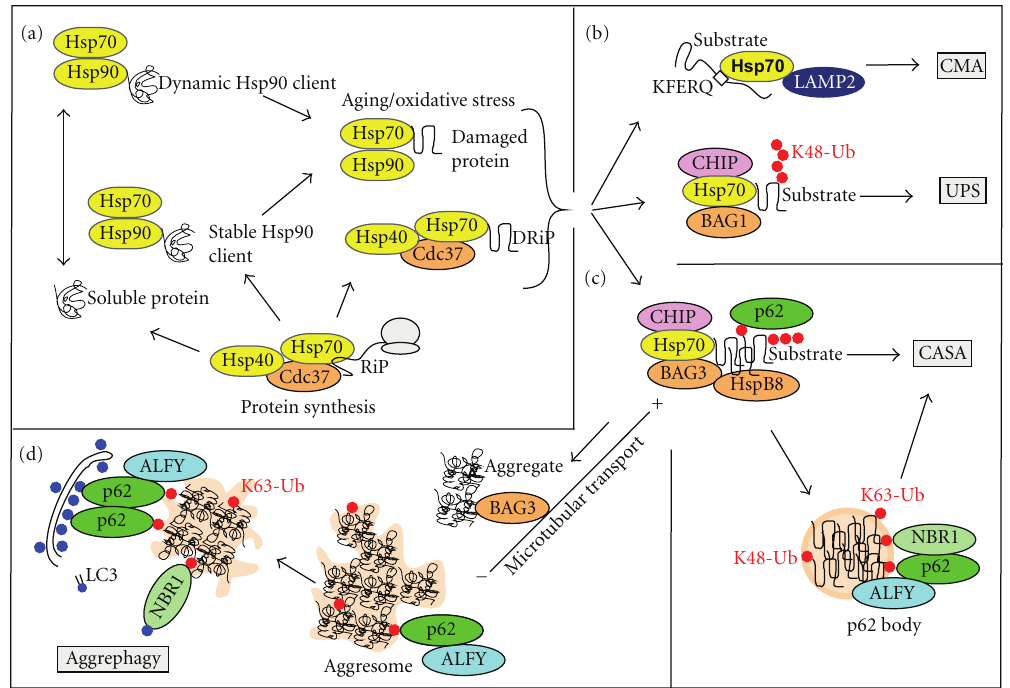
Figure 2: Protein degradation assisted by heat shock proteins and their co-chaperones. (a) Substrates selected for degradation by heat shock proteins are either defective ribosomal products (DRiPs) or Hsp90 client proteins that start to unfold or aggregate. Formation of the latter type of substrate is increased under conditions of oxidative stress or during aging. (b) Misfolded and monomeric substrates bound to Hsp70/Hsc70 are preferentially degraded by CMA or by the UPS. (c) In response to aggregation, or if the capacity of CMA and the UPS is insu ffi cient, substrates are degraded by chaperone-assisted selective autophagy (CASA). This process relies on the co-chaperones BAG3 and HspB8, the E3 ubiquitin ligase CHIP, and autophagy receptors such as p62. The process may also rely on the assembly of the misfolded substrates into p62 bodies. (d) If degradation of misfolded substrates is impaired, BAG3 interacts with dynein and transport protein aggregates along microtubules to the aggresome. The contents of aggresomes may subsequently be degraded by aggrephagy.